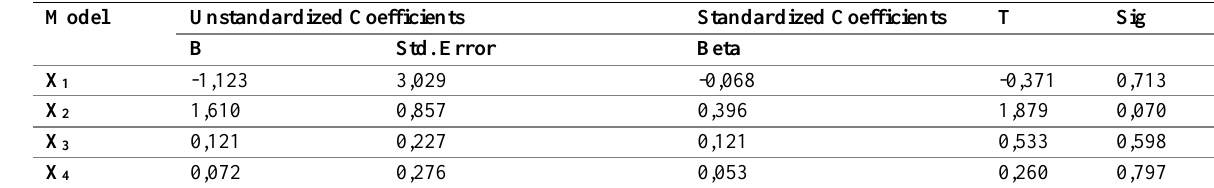
Table 5: Coefficient Value